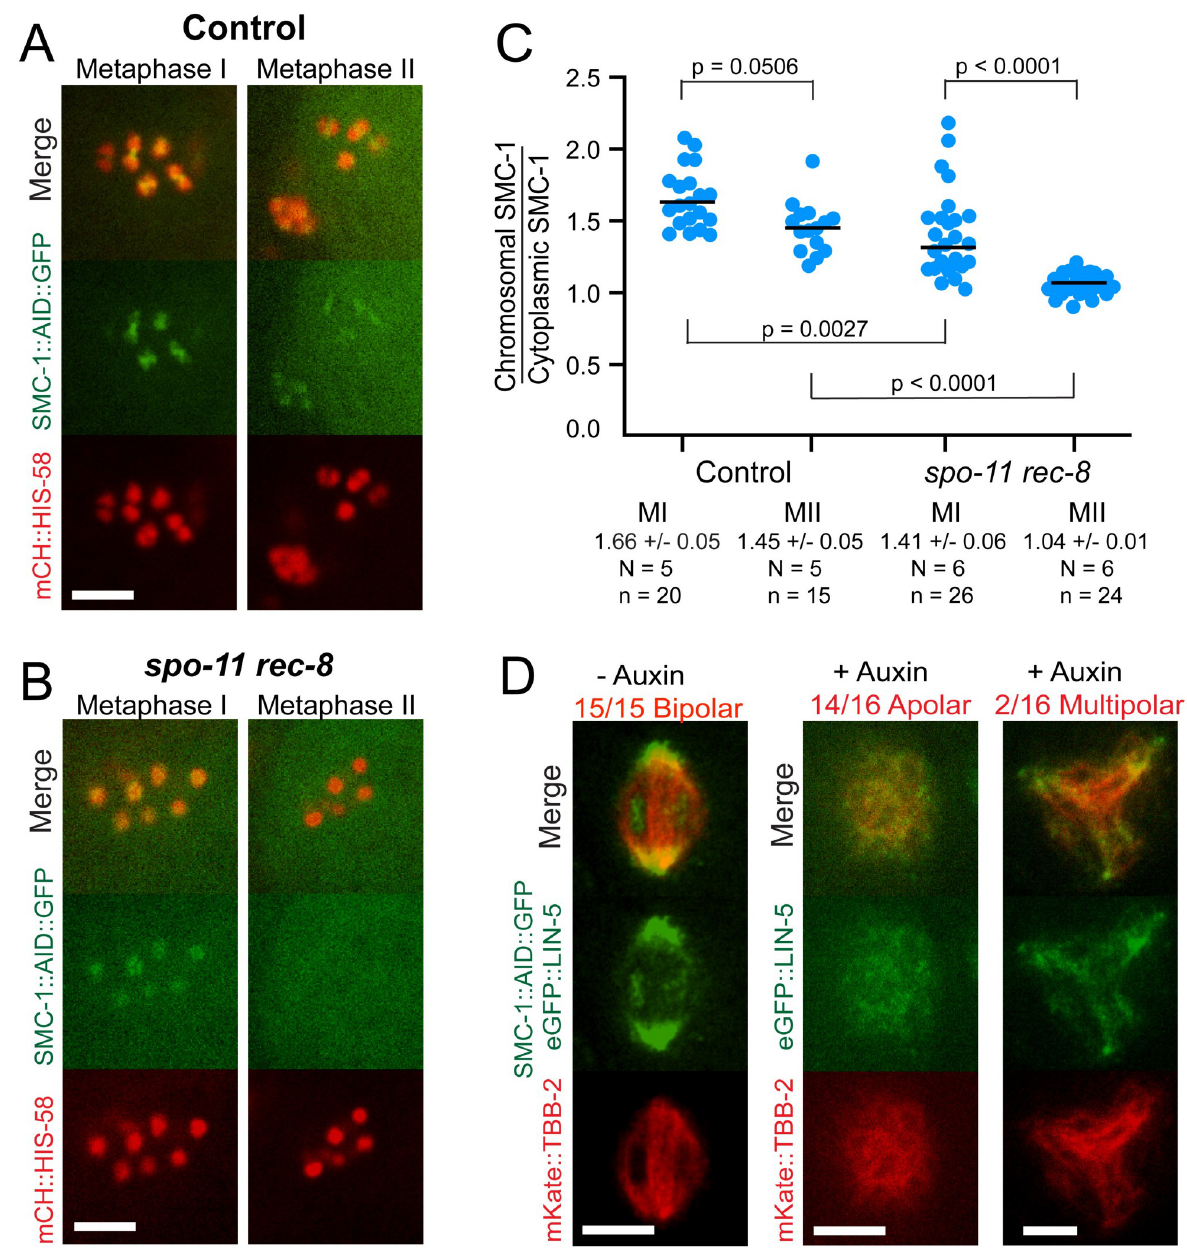
Fig 4. Non-cohesive cohesin is sufficient for bipolar spindle formation. Single-plane time-lapse images from control (A) and spo-11 rec-8 (B) embryos expressing SMC-1::AID::GFP and mCH::HIS-58. (C) SMC-1::AID::GFP pixel intensities on individual chromosomes were determined relative to cytoplasmic background. N, number of embryos. n, number of chromosomes. (D) C . elegans expressing SMC-1::AID::GFP, eGFP::LIN-5 and mkate::TBB-2 were incubated overnight in the presence or absence of auxin. Single slices of z-stack MI images are shown. All bars = 4 μ m. (BIR-1 in C . elegans ) subunit of the CPC binds to the phosphorylated histone thereby recruit- ing Aurora B to chromosomes [32,38,39]. In C . elegans , haspin (HASP-1) is required to pro- mote recruitment of Aurora B (AIR-2) to the midbivalent region in diakinesis oocytes [40] and AIR-2 is essential for bipolar meiotic spindle assembly in C . elegans [19,20]. Therefore we hypothesized that chromatids that lack cohesin-recruited AIR-2 would be unable to form